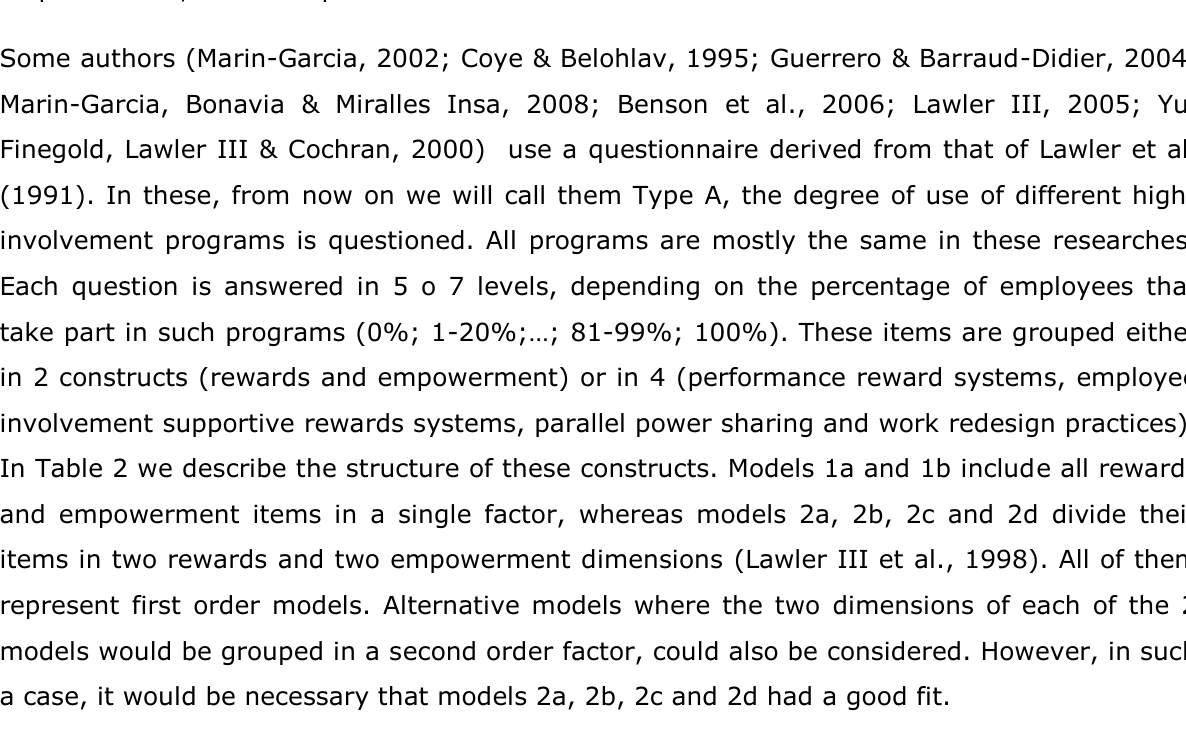
Table 1. Categories that make up high-involvement practices (Lawler III, 1991; Lawler III et al., 1998) In order to measure the degree of use of high-involvement practices related to rewards and empowerment, different questionnaires have been